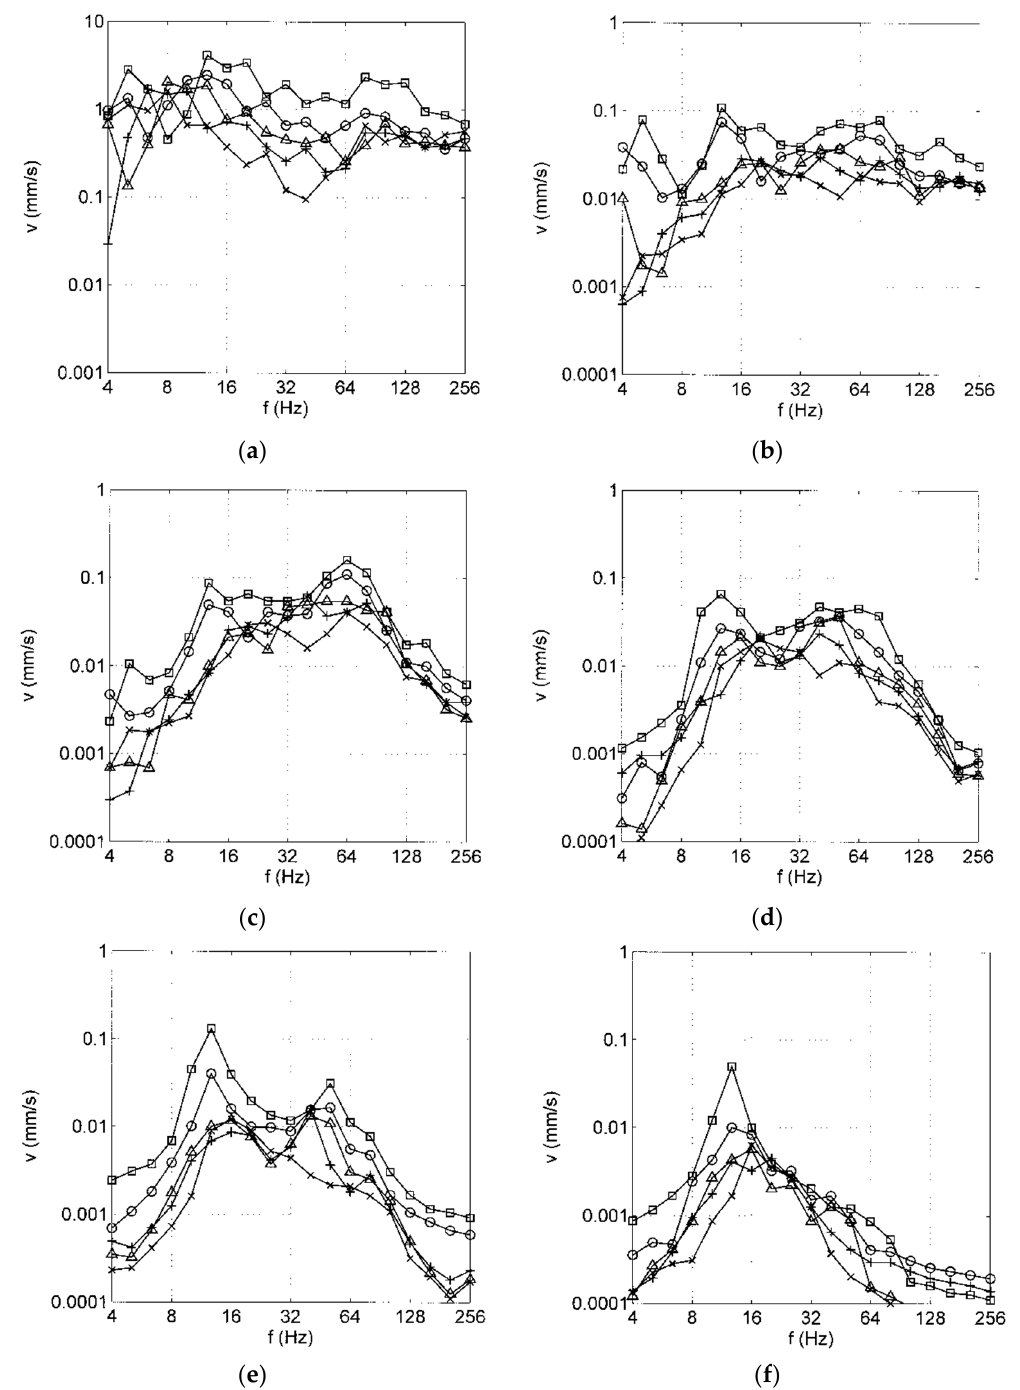
Figure 1. ( a ) Measurement points of the railway vehicle (passenger car) for the test runs, axle boxes A1, A2, bogie B1 and B2, carriage C1 and C2, right hand side, A3, A4, B3, B4, C3, C4 symmetrically on the left hand side; ( b ) one-third octave band spectra of the accelerations of the railway vehicle Figure 5. Vibrations of the soil, one-third octave band spectra for different train speeds  160,  Figure 5. Vibrations of the soil, one‑third octave band spectra for different train speeds running with v T = 160 km/h,  ,  wheelset A1 and A2,  ,  vertical bogie part B1 and B2,  125,  100,  80,  63 km/h, at distances ( a ) 0 m (rail) ( b ) 2.5 m, ( c ) 5 m, ( d ) 17.5 m, ( e ) 30 m, ( f ) 100 horizontal bogie part B1,  ,  car body part C1 and C2; ( c ) particle velocities of the track  ,  left m. and right rail,  ,  sleeper 1 and 2,  , sleeper horizontal,  sub soil at 2.5 m